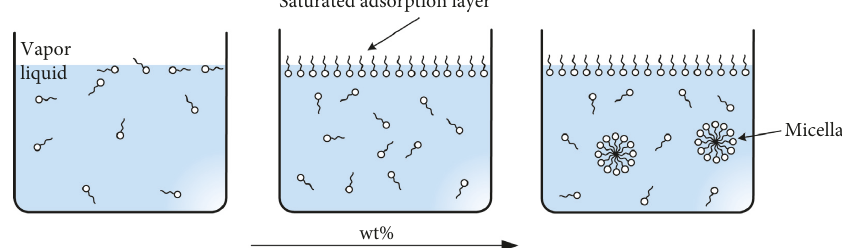
Figure 9: Adsorption state of a surfactant molecule in an aqueous solution with concentration change.